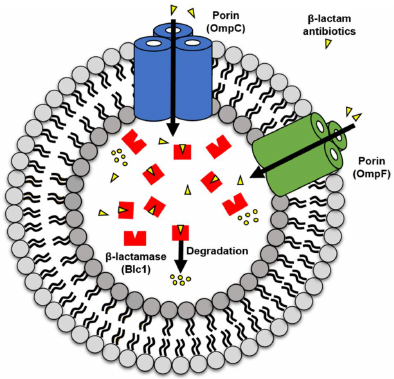
Figure 1. Predictive mechanism of β-lactam antibiotics degradation by outer membrane vesicles (OMVs) from β-lactam-resistant Escherichia coli (RC85 + ). OMVs take up β-lactam antibiotics into their lumen through porin channels (OmpC and OmpF) and the β-lactamase (Blc1) in the lumen hydrolyzes the β-lactam antibiotics confined in the lumen of OMVs.